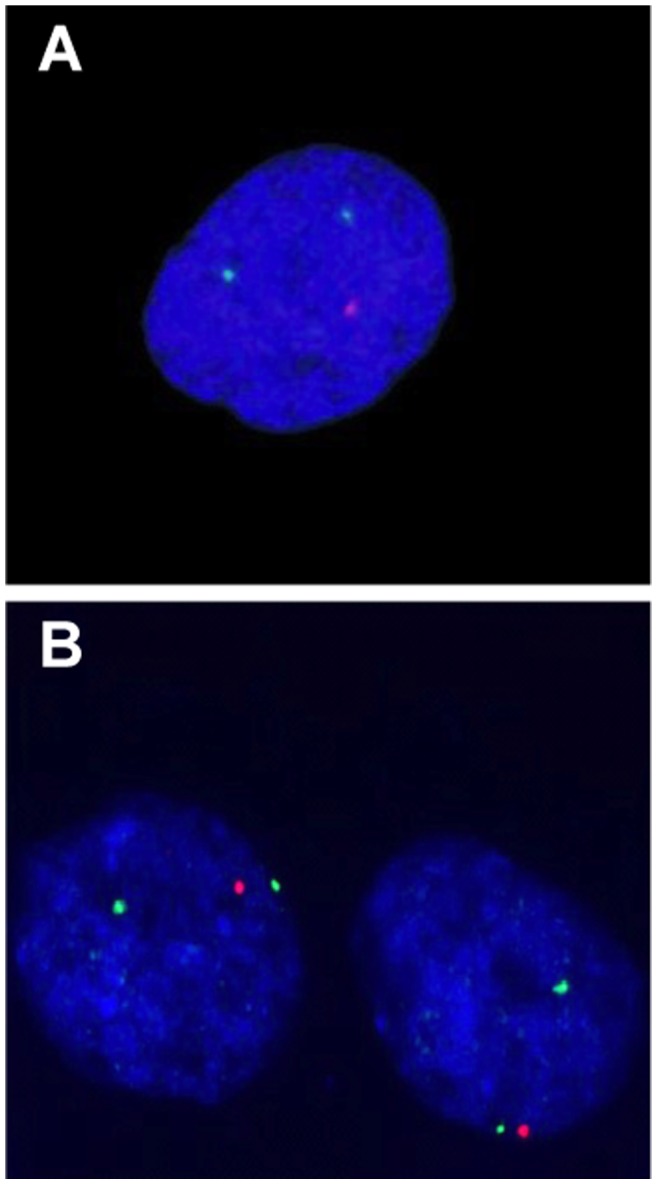
FISH with probes in the region of common deletion in a BRCA2-mutant tumor.A, chromosome 13; B, chromosome 14. Red: probe in the deleted region; Green, pericentromeric probe. Each nucleus contains two green spots and one red spot, indicating that the tumor is diploid for chromosomes 13 and 14 but has heterozygous deletions in the regions tested by the red probes.